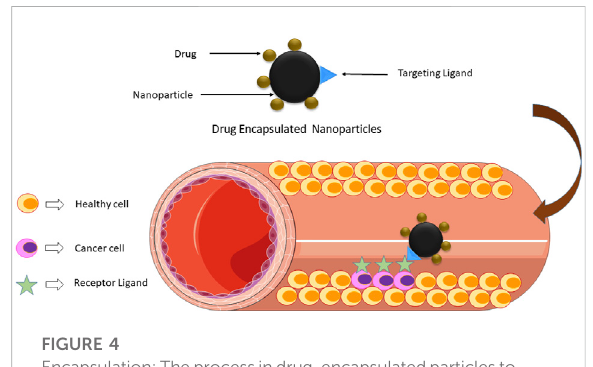
FIGURE 4 Encapsulation:Theprocessindrug-encapsulatedparticlesto clear infected cells.